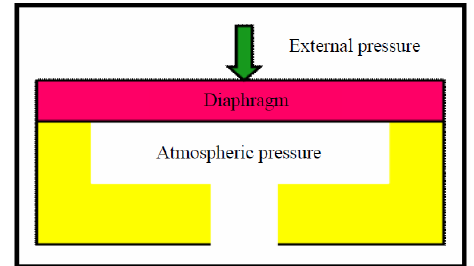
Fig. 4 Schematic representation of gauge or relative pressure